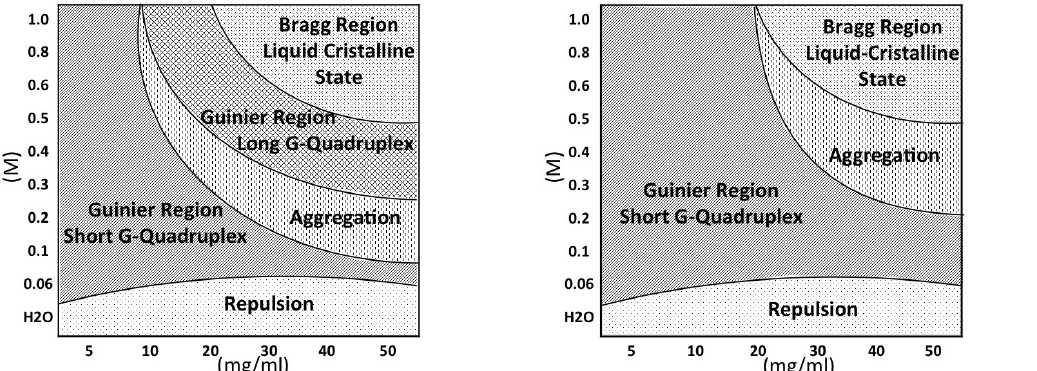
Figure 15. Phase diagrams for GMPNa 2 in K + (left side) and in Na + (right side). Repulsion : very short, strongly interacting quadruplexes. A correlation band characterise the SAXS curves; Guinier Region—Short G-Quadruplex : short quadruplexes. SAXS curves show an extended Guinier region; Aggregation : elongated, polydisperse quadruplexes. In the SAXS curves, the Guinier region is lost; Guinier Region—Long G-Quadruplex : elongated, monodisperse quadruplexes. SAXS curves show an extended Guinier region; Bragg Region—Liquid-Crystalline State : long quadruplexes, packed according a partially ordered hexagonal lattice. SAXS curves show Bragg